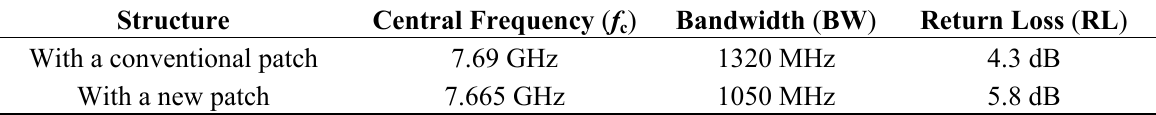
Table 2. Comparison between the performances of both dual-mode filters.